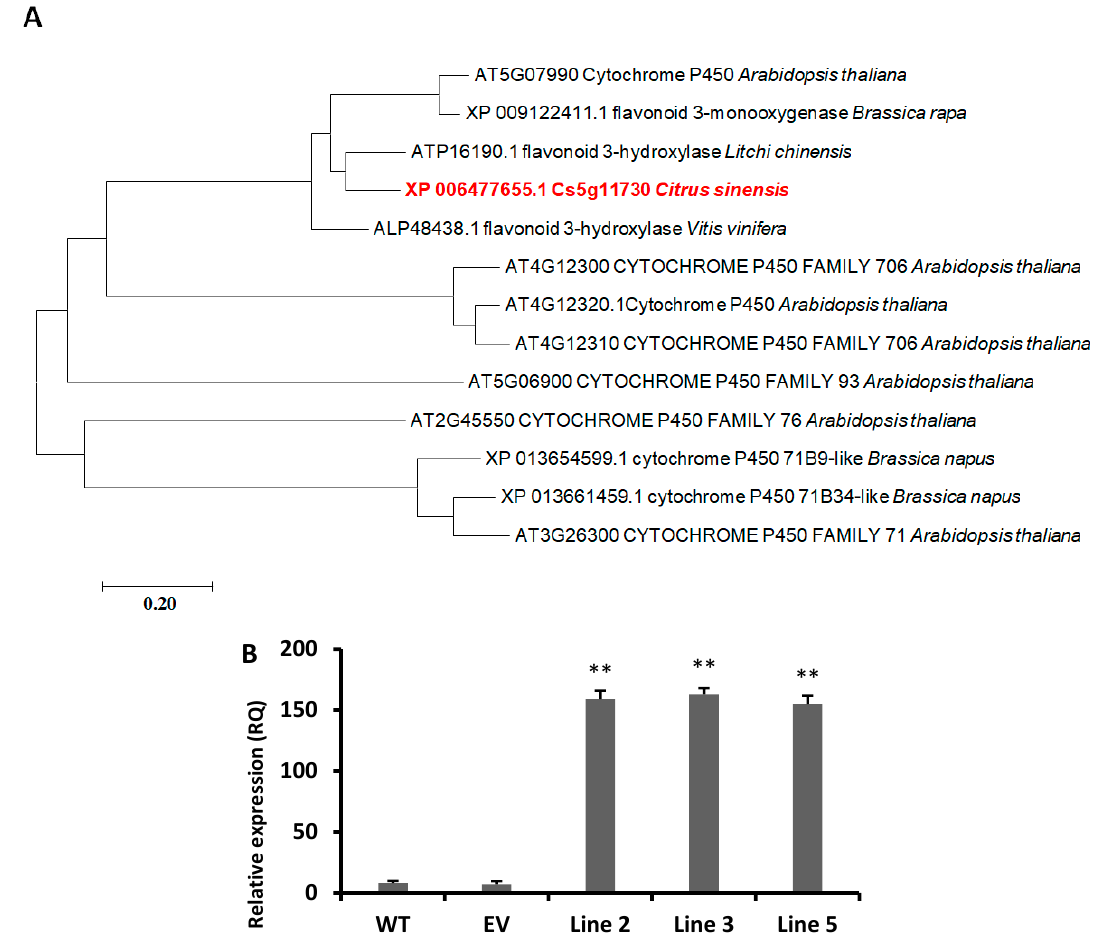
Figure 1. Phylogenetic analysis and gene expression pattern of the CsCYT75B1 (CYT) gene. ( A ) Phylogenetic analysis of CsCYT75B1 gene with its homologous genes from other plant species. ( B ) Gene expression pattern of CsCYT75B1 in overexpressed (OX) Arabidopsis lines. Wild type (WT), and empty vector (EV) plants. A Students t -test was used to compare CYT-OX and WT at ** p < 0.01. Each value is a mean of three replicates.